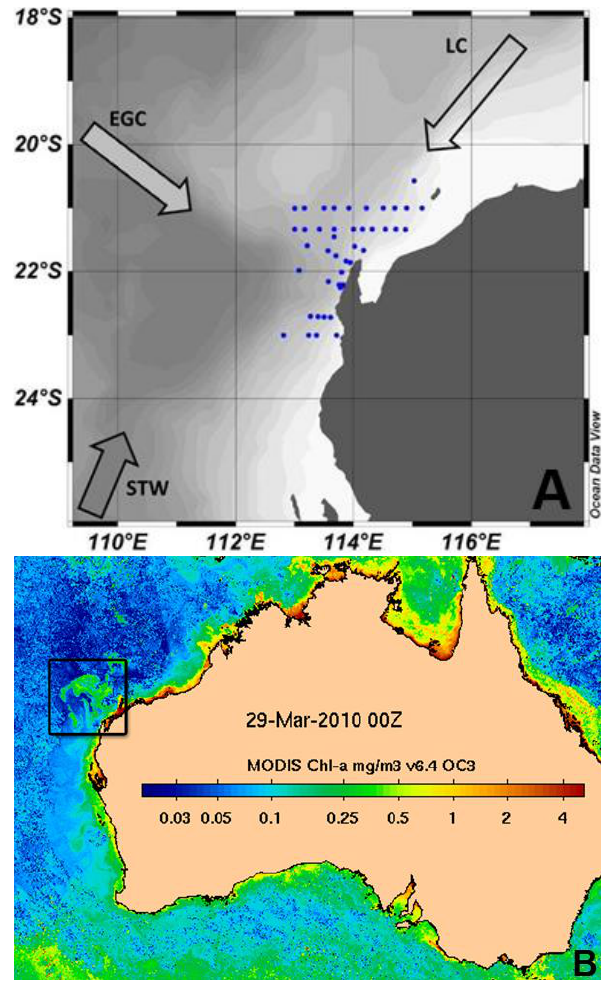
Fig. 1. (A) Map of study area showing sampling locations as filled